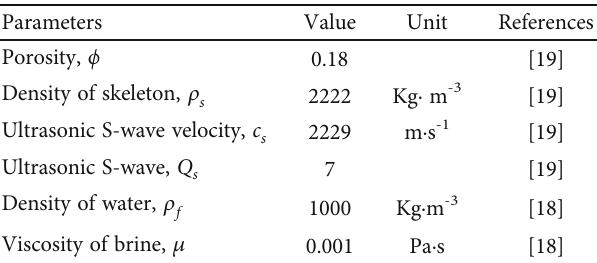
Table 2: Parameters of water-saturated limestone under di ff erential pressure of 5